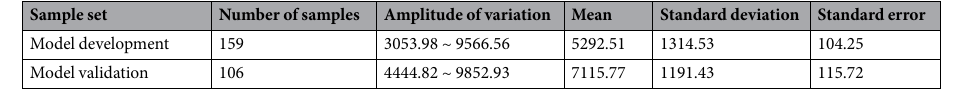
Table 1. Distribution of the yield in the model development and model validation (yield unit: kg ha -1